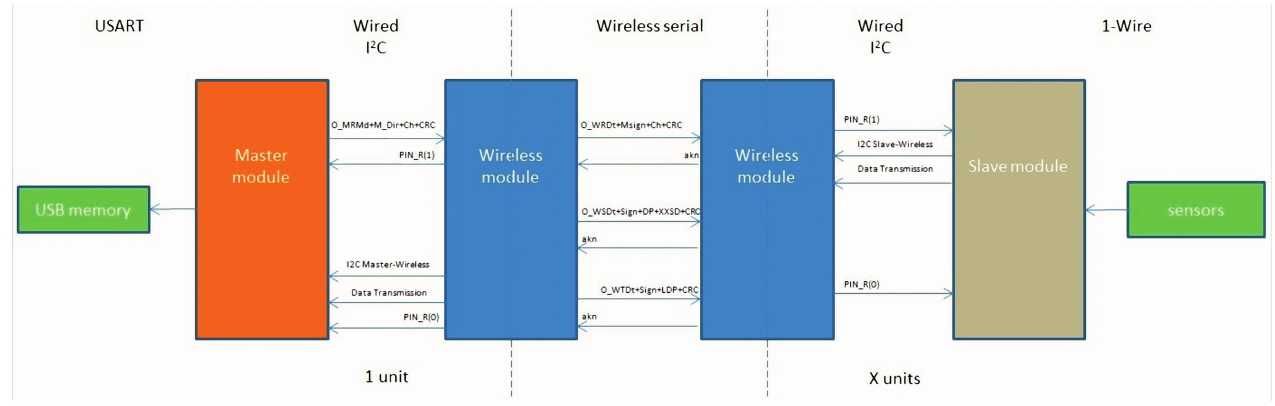
Figure 10. Global communication example.